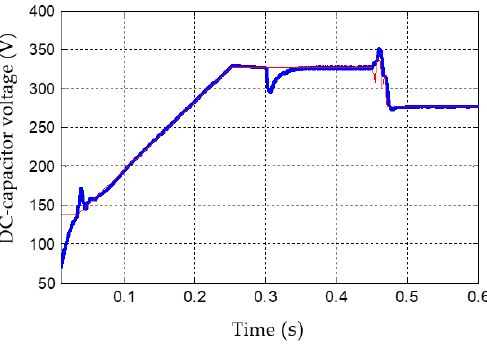
Figure 13. The DC-capacitor voltage evolution when a step variation of the load occurs: prescribed (in red); real (in blue).